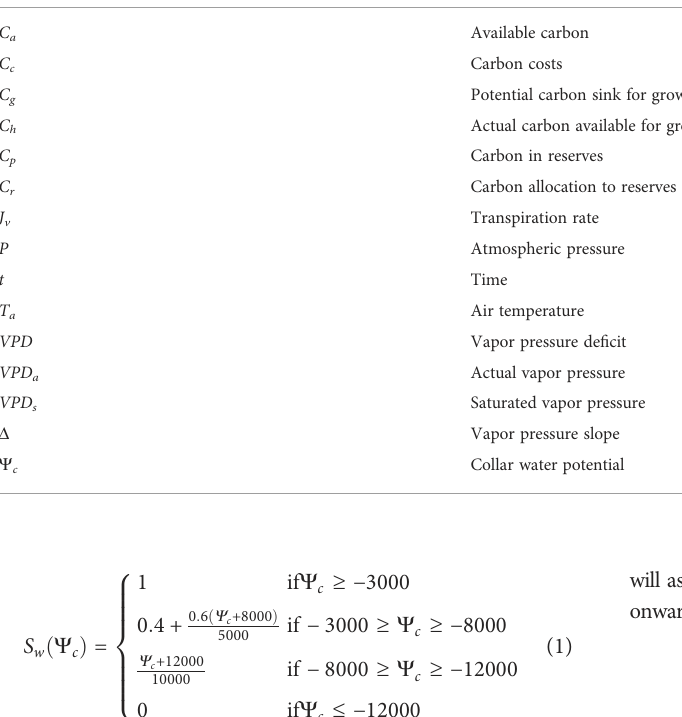
TABLE 2 Previously existing OpenSimRoot derived quantities and model inputs.